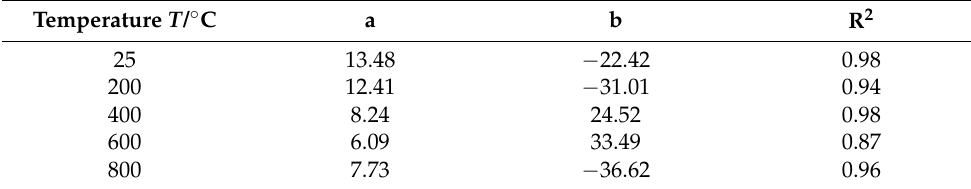
Figure 9. Relationship between the dynamic peak stress and the impact velocity. Table 1. Fitting parameters for the peak stress and the impact velocity.